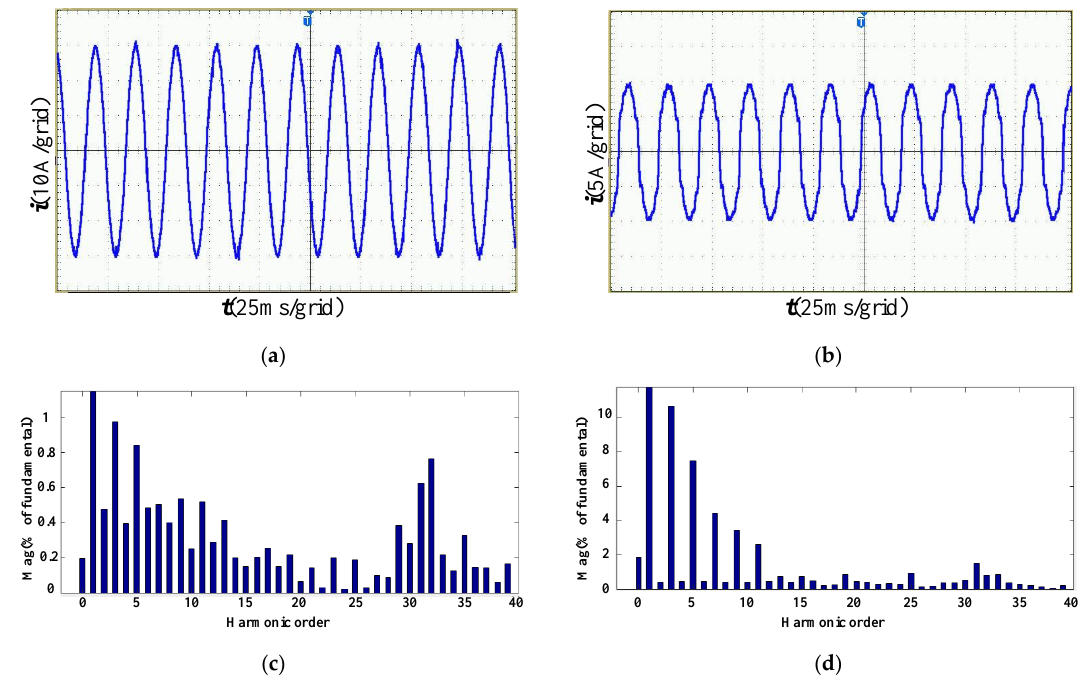
Figure 26. Grid current, HCGI output current and their THD analysis without G d . ( a ) Output current; ( b ) Grid current; ( c ) Output-current THD analysis (fundamental component = 29.45 A, THD = 3.43%); ( d ) Grid-current THD analysis (fundamental component = 9.686 A, THD = 15.23%).